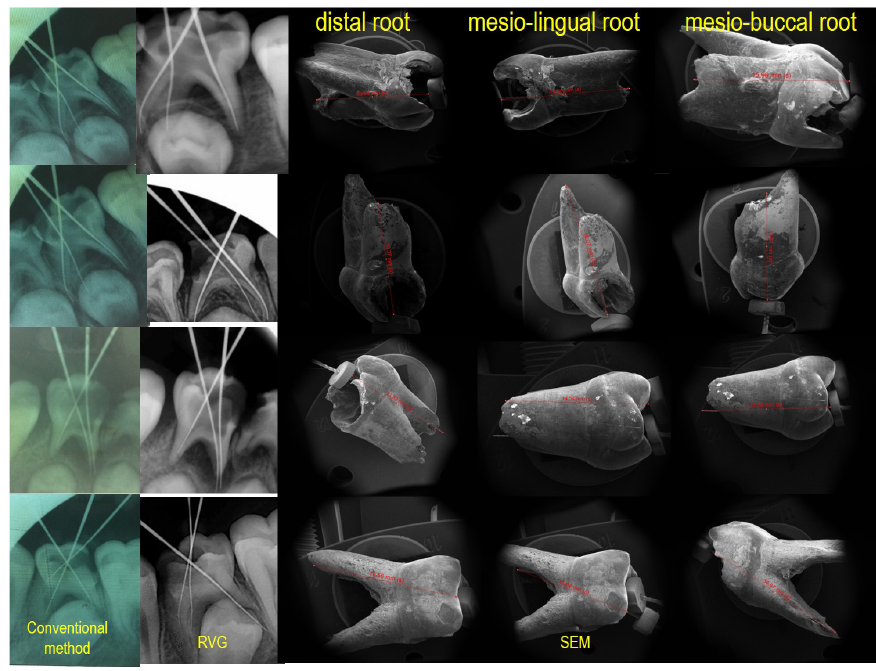
Figure 1. Root canal length measurement for three